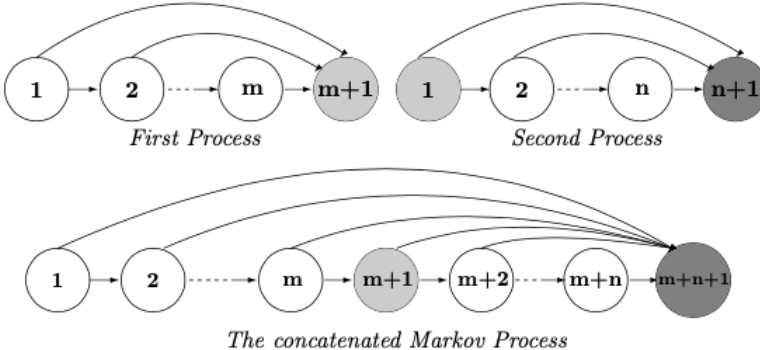
Figure 1. Two concatenated Markov processes. The resulting Markov chain with the final state m + n + 1 from any transitional state.